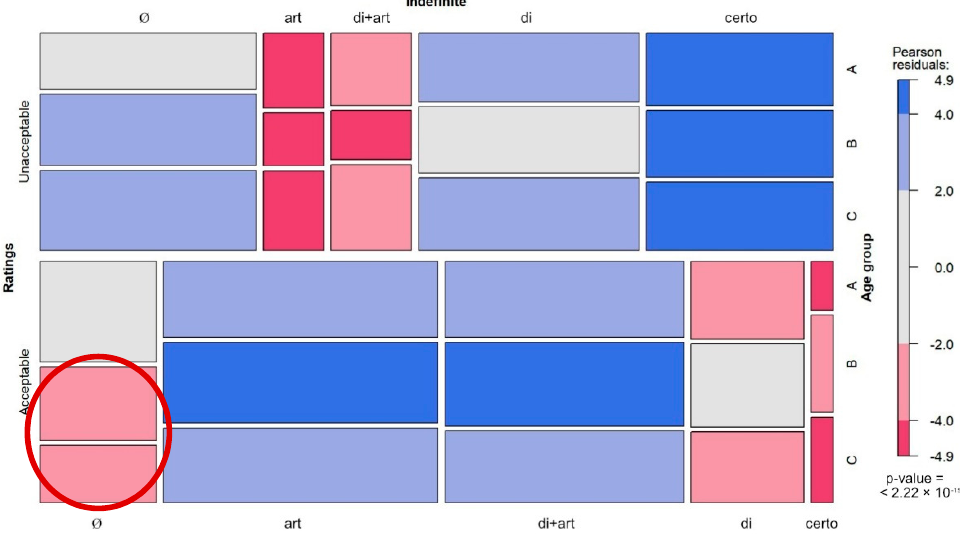
Figure 4. (Un)acceptability rate of each indefinite determiner in the age groups. The area marked by the red circle indicates that ZERO is less accepted by groups B and C.